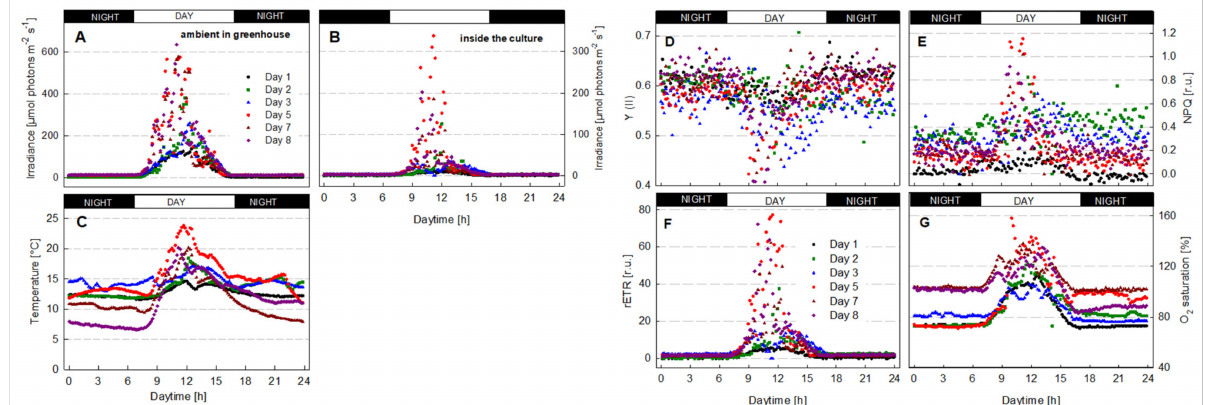
Figure 7. Diurnal changes of growth conditions and photosynthetic activity in the Monoraphidium culture (class Chloro- phyceae) grown during an 8-day trial in an outdoor thin-layer raceway pond (November–December 2020). ( A ) Ambient irradiance intensity in the greenhouse; ( B ) irradiance intensity in the culture measured in the middle of the photic zone (the depth of light penetration); ( C ) culture temperature; ( D ) actual photochemical yield ∆ F (cid:48) /F M (cid:48) ( E ) non-photochemical quenching NPQ; ( F ) electron transport rate ETR rETR = ∆ F (cid:48) /F M (cid:48) × PAR estimated in the middle of the photic zone; ( G ) dissolved oxygen concentration in the culture; ( E ) relative electron transport